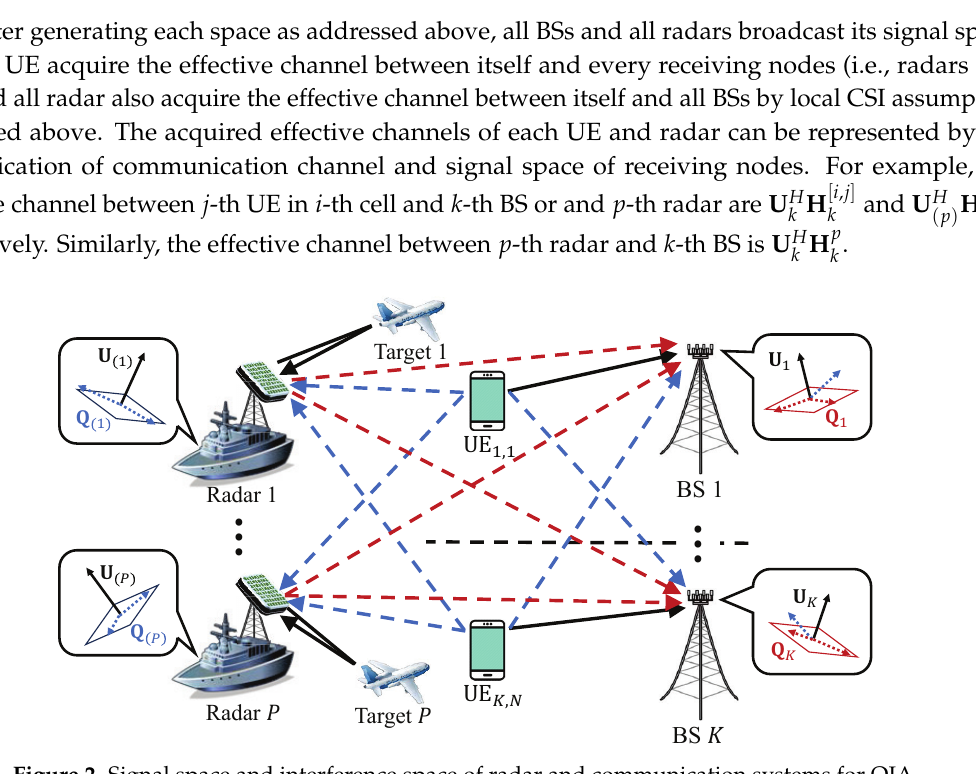
(cid:1842) Figure 2. Signal space and interference space of radar and communication systems for